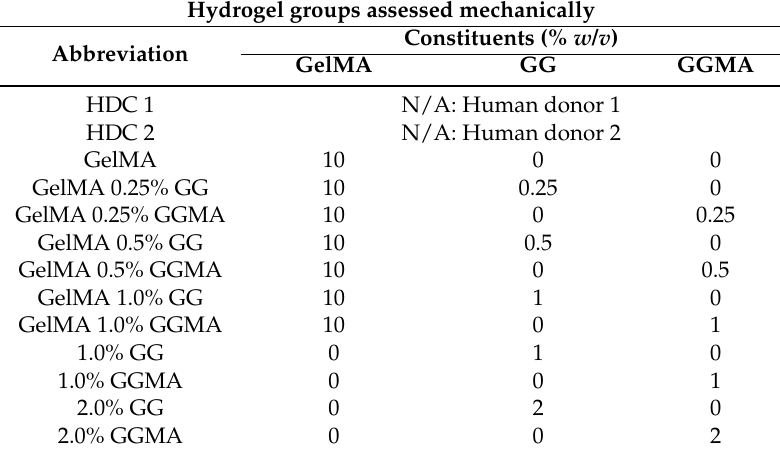
Table 3. Summary of hydrogel groups used for mechanical characterization. All gels were mixed with NaCl + mannose. HDC = human donor cartilage; GelMA = gelatin methacrylamide; GG = gellan gum; GGMA = gellan gum